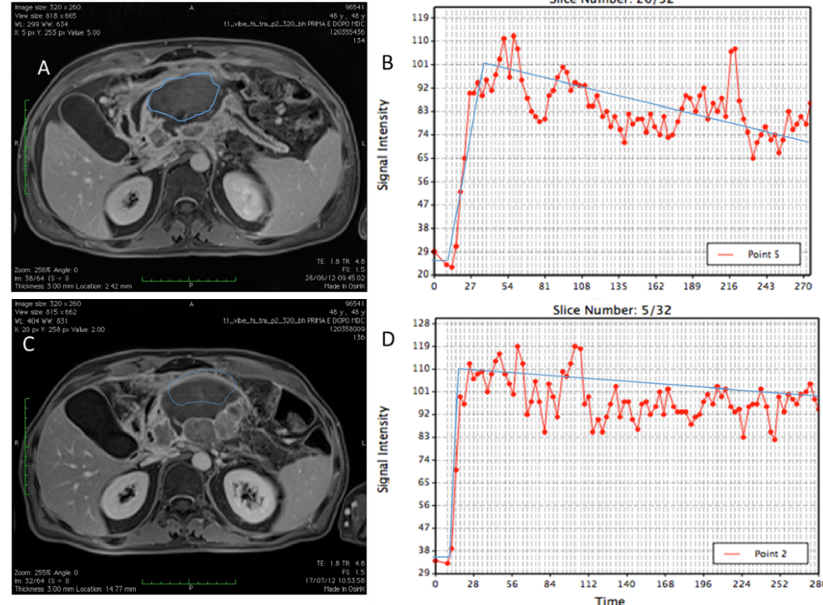
Figure 4. Pancreatic cancer treated with ECT. DCE-MRI pre- ( A ) and post-treatment ( C ) with time intensity curves ( B , D ) obtained on segmented region of interest show reduction of lesion enhance- ment.